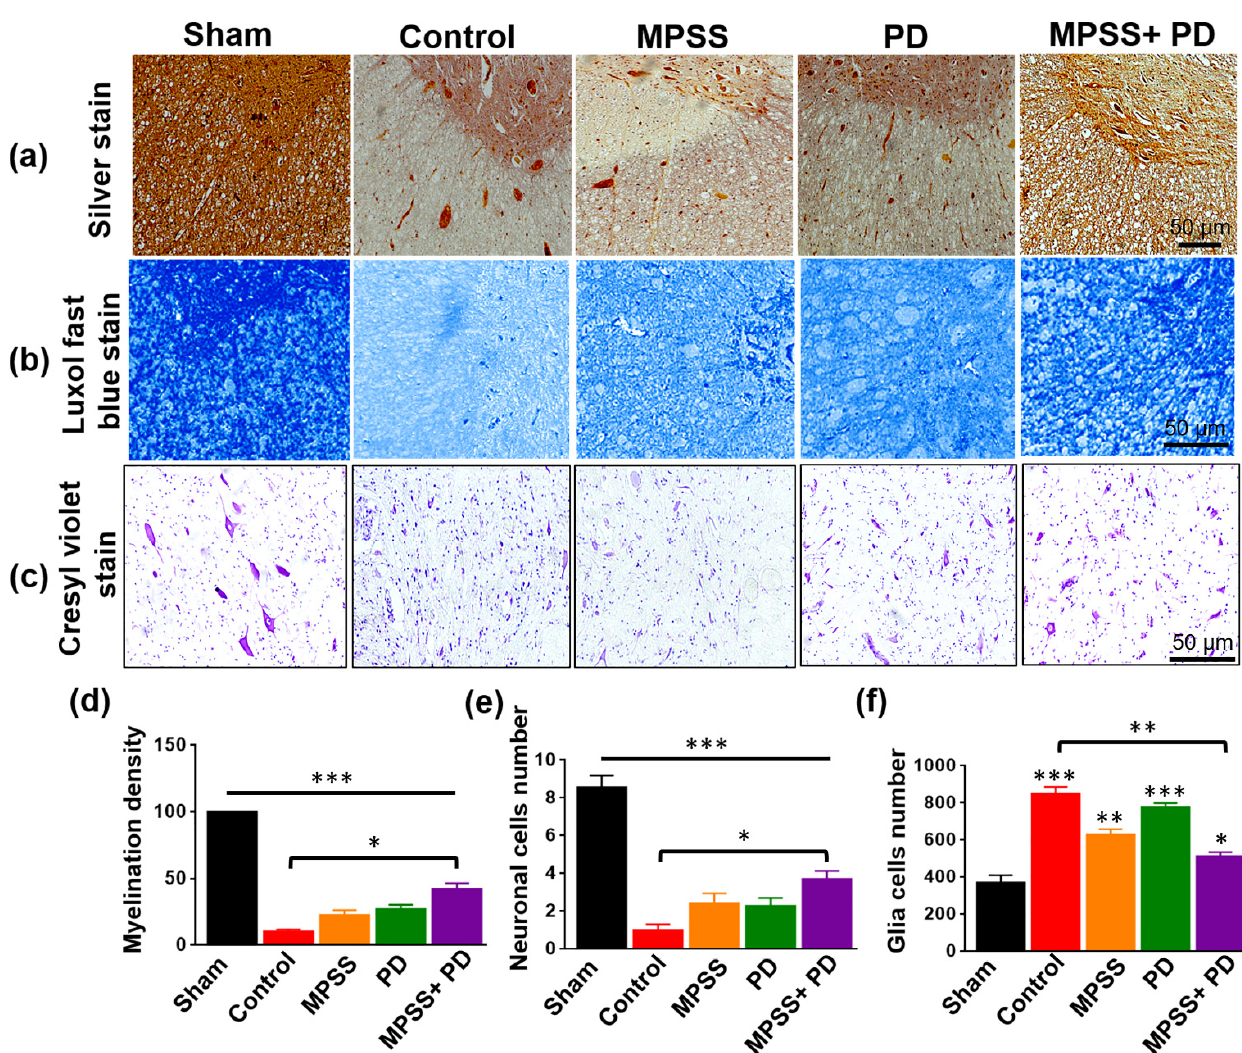
Figure 6. The combination groups of MPSS+PD150606 preserve the axons’ myelination after SCI. ( a ) Histological analysis of spinal cord lesions stained with Bielschowsky’s silver, and ( b ) Luxol fast blue for myelination, and ( c ) Cresyl violet stain for neuronal cell bodies and Nissl granules. All groups exhibited severe demyelination of nerve fibers, neuronal loss, and gliosis in the SCI lesion. The myelination density, neuronal cells, and glia cells were dramatically preserved in the combination group compared to other groups. Scale bare = 50 µm. ( d ) Quantitative analysis of the average myelination density, ( e ) neuronal cell number (cells/0.1 mm 2 ), and ( f ) Glial cells number (cells/0.1 mm 2 ) in the indicated groups. Ten images from each group were used for data quantification. Data are presented as the mean ± SD. * p <0.05, ** p <0.01, *** p <0.001, and ns indicates non-significant.